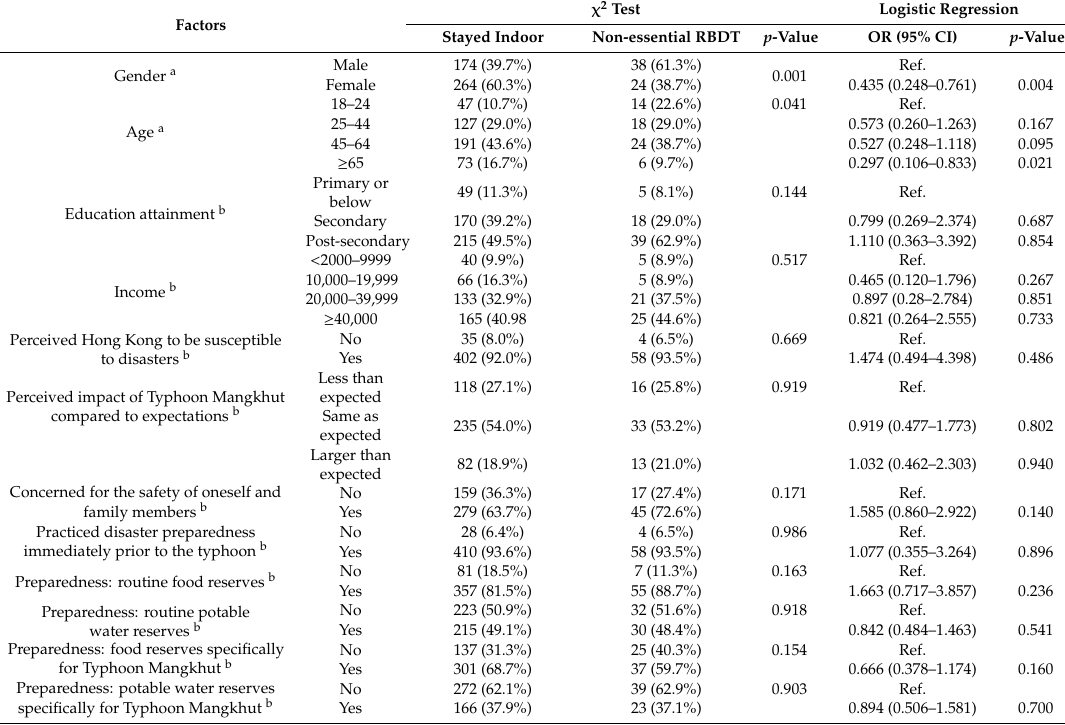
Table 2. Chi-square comparison and multivariable logistic regressions of the associating factors towards non-essential